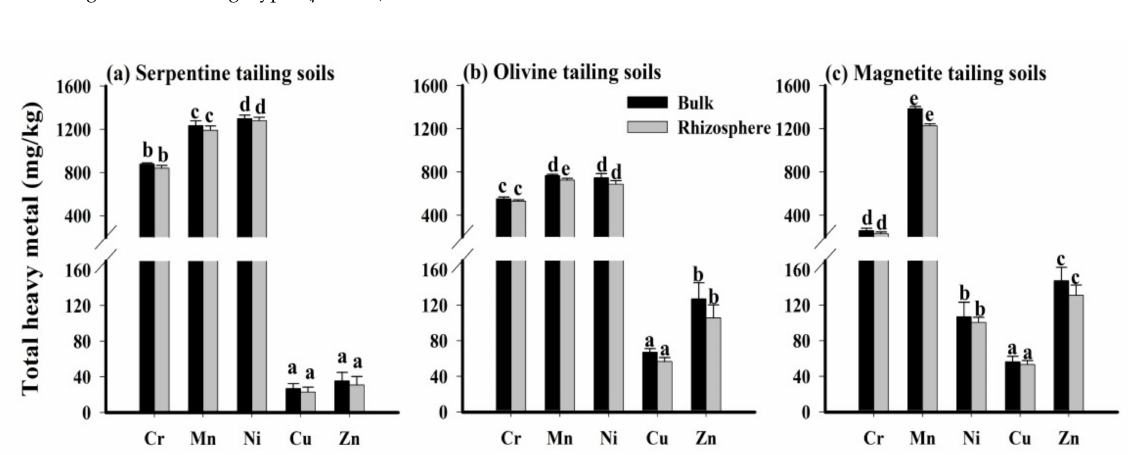
Figure 1. Total heavy metal concentrations in tailing soils. ( a ) Serpentine tailing soils, ( b ) Olivine tailing soils and ( c ) Magnetite tailing soils after growth of Imperata Cylindrica . Bulk: Bulk tailing soils; Rhizosphere: Rhizosphere tailing soils. The letters in the figure represent concentration differences among different heavy metals ( p < 0.05). The same letter represents no significant